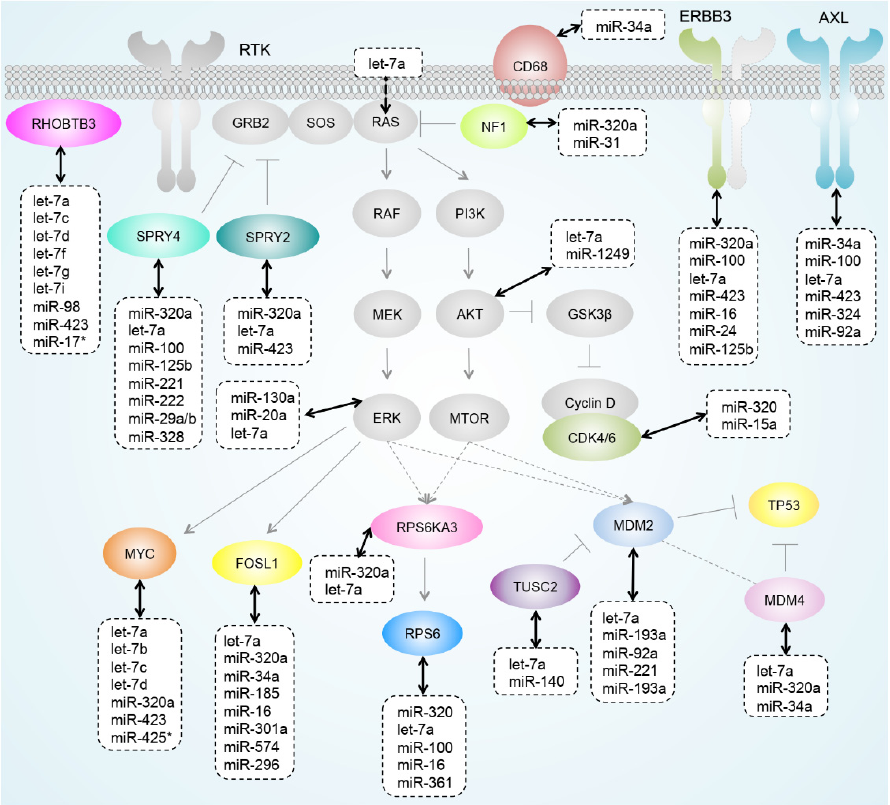
Figure 9. Overview of selected miRNA – mRNA interactions identified by qCLASH in melanoma cells. The graph summarizes herein and previously identified miRNA – target gene interactions, which are part of important signaling pathways in